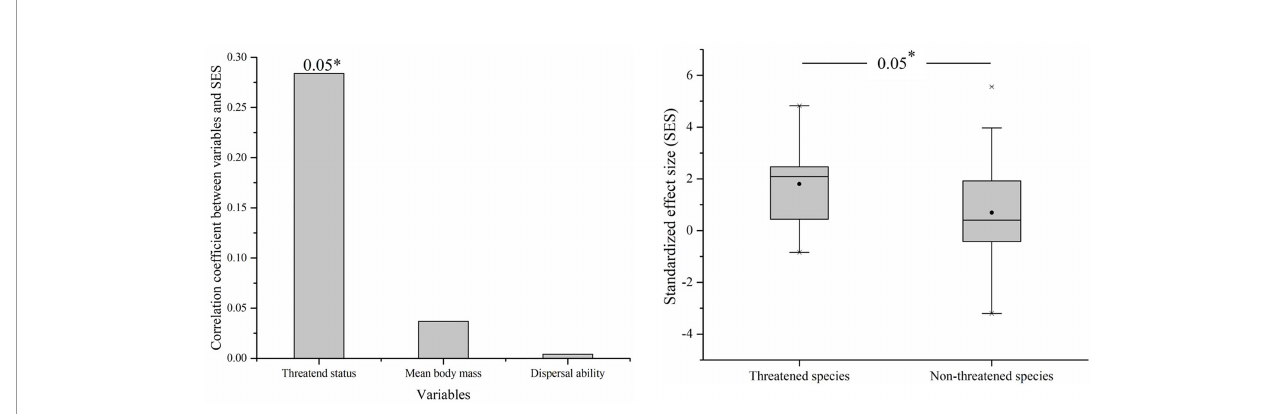
FIGURE 4 | Correlation between standardized effect size (SES) and variables (threatened species, mean body mass, and dispersal ability) ( left ) and the SES between threatened species and non-threatened species ( right ). Black circles represent mean values, horizontal bars within boxes represent median values, the upper and lower limits of boxes represent the maxima and minima, respectively, and whiskers represent 1% and 99%. *means signi fi cant at the